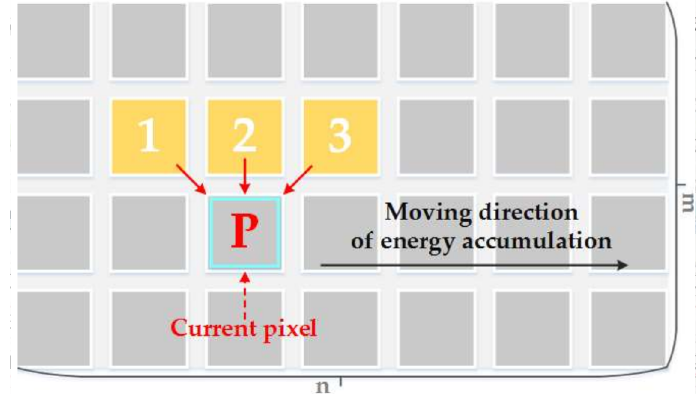
Figure 1. The schematic diagram of Duplaquet’s energy criterion.